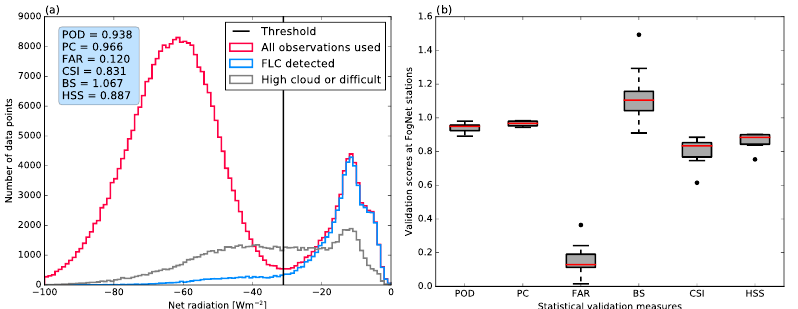
Figure 3. (a) The aggregated validation of the satellite-derived FLC product at all stations of the time period of 2015–2017, (b) the variability of validation measures across the used FogNet stations. The median is represented in boxes by the red horizontal line; the boxes show the interquartile range, the whiskers expand the boxes by up to 1.5 interquartile ranges. The station GK accounts for all outliers.